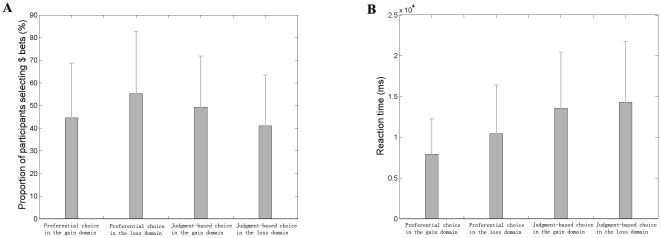
Behavioral results.A. Mean proportion of participants selecting $ bets. B. Reaction time as a function of task. The error bars denote the standard deviation.